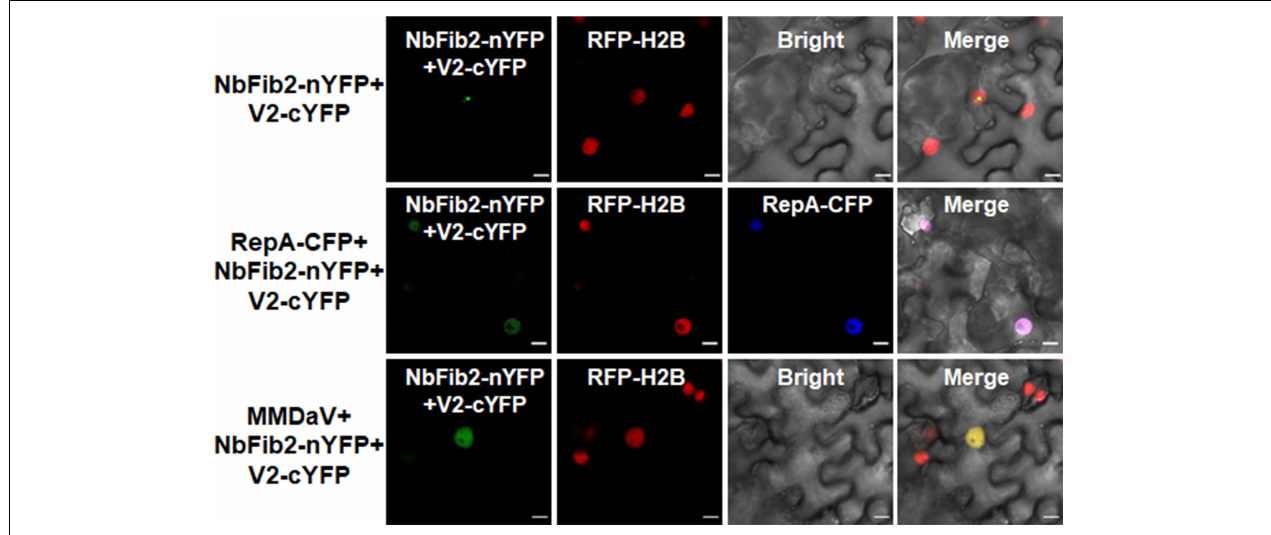
FIGURE 6 | Representative images showing the impact of RepA and MMDaV on the localization of V2-NbFib2 complex. Agrobacteria cultures harboring a cyan fluorescent protein-tagged RepA (RepA-CFP) or infectious clone of MMDaV was coexpressed with the BiFC combination constructs of NbFib2-V2. Images were captured at 48 hpi. Scale bars correspond to 10 µ